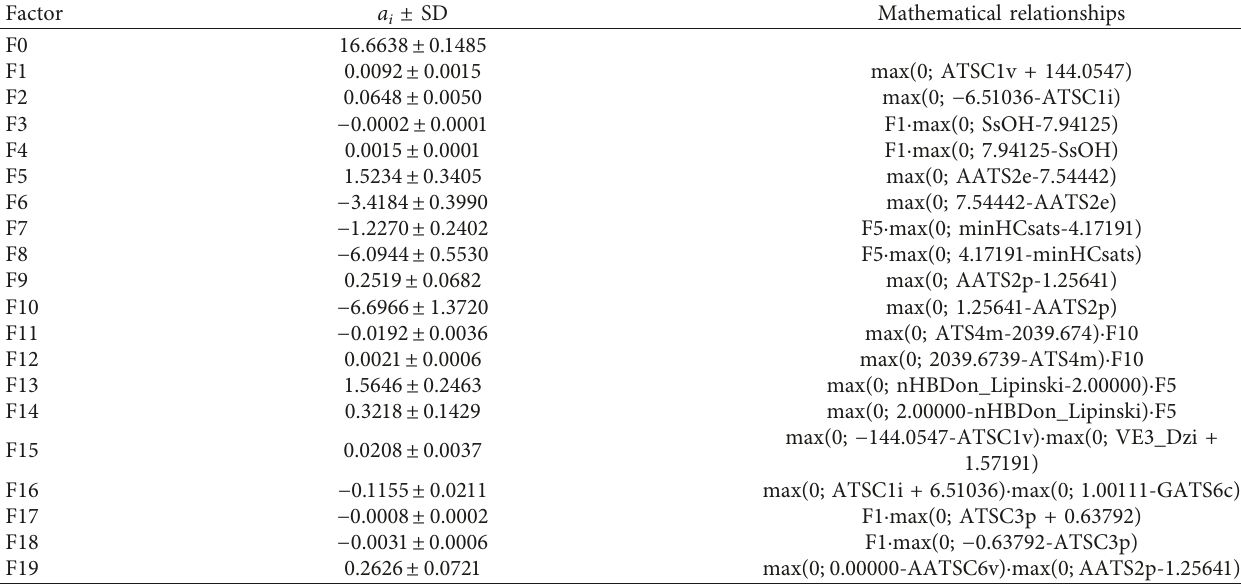
Table 1: Regression factors along with their weights defining the d (25, 2) MARSplines model in Eq. (4). Factor